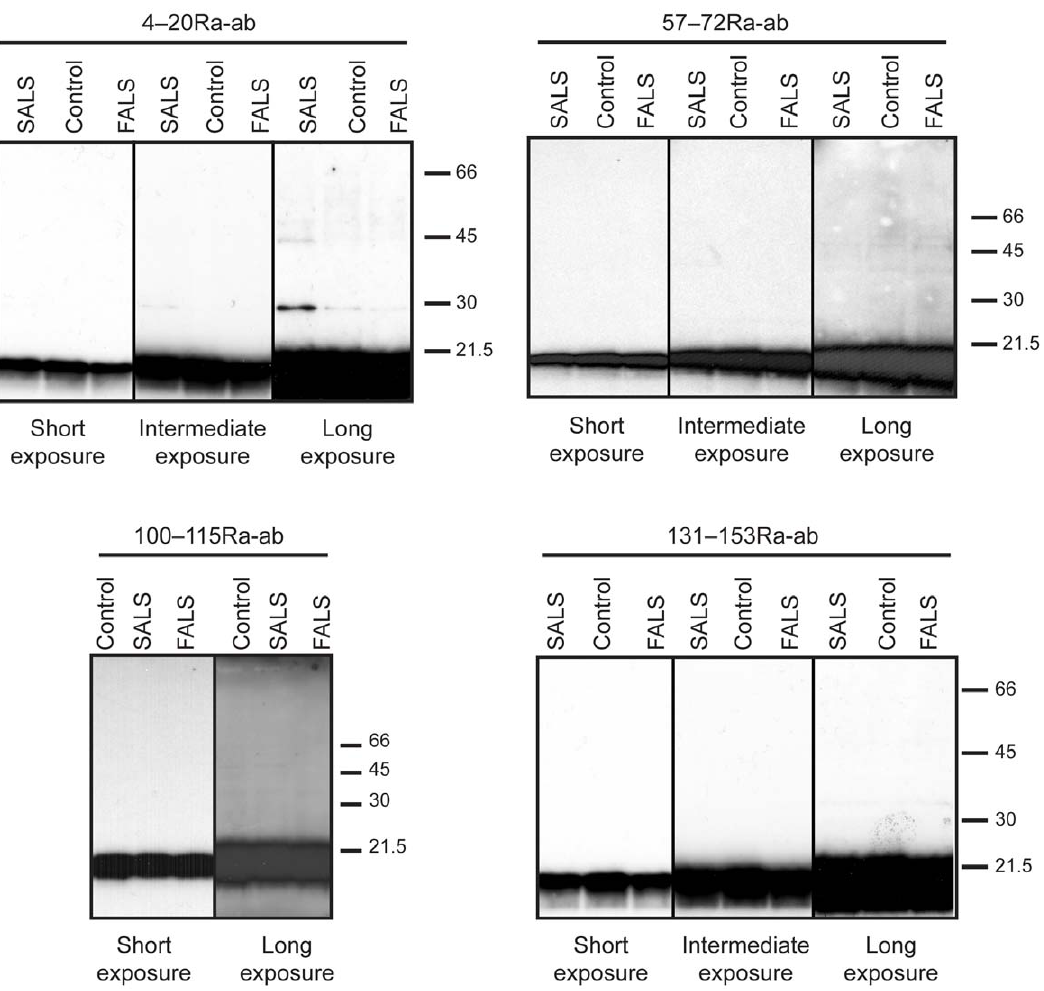
Figure 3. Analysis of SOD1 by western immunoblot. Homogenates of tissue from the temporal lobe, the precentral gyrus, and the spinal cord ventral horns from 5 control patients, 5 SALS and 4 FALS patients were analyzed by western immunoblots, using the 4–20Ra-ab, 57–72Ra-ab, 100– 115Ra-ab and 131–153Ra-ab anti-SOD1 peptide antibodies. Analyses of lumbar spinal cord ventral horns are here shown as examples. All figures depict the same set of extracts and short, intermediate and long exposures are presented. Upon long exposure a weak band at about 28 kDa was seen with the 4–20Ra-ab anti-SOD1 antibody in one of the five SALS samples. The band was probably unspecific since it was not seen with the other antibodies. The intensity was estimated at , 0.5% of the SOD1